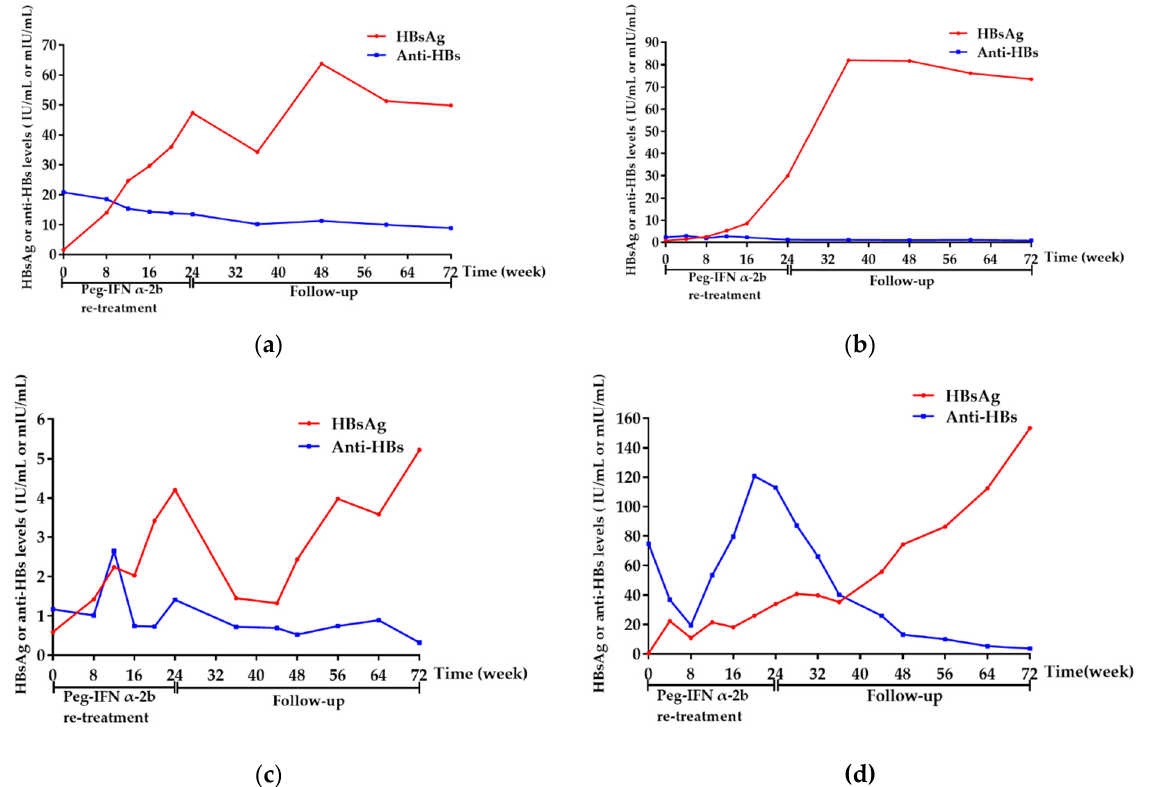
Figure 5. Dynamics of HBsAg and anti-HBs of the 4 patients without HBsAg clearance. ( a ) Dynamics of HBsAg and anti-HBs of the No. 12 patient. ( b ) Dynamics of HBsAg and anti-HBs of the No. 14 patient. ( c ) Dynamics of HBsAg and anti-HBs of the No. 18 patient. ( d ) Dynamics of HBsAg and anti-HBs of the No. 21 patient. Week 0 was defined as the time when the patients were enrolled in this study. Abbreviations: HBsAg, hepatitis B surface antigen; anti-HBs, hepatitis B surface antibody; Peg-IFN- α , peginterferon alpha.